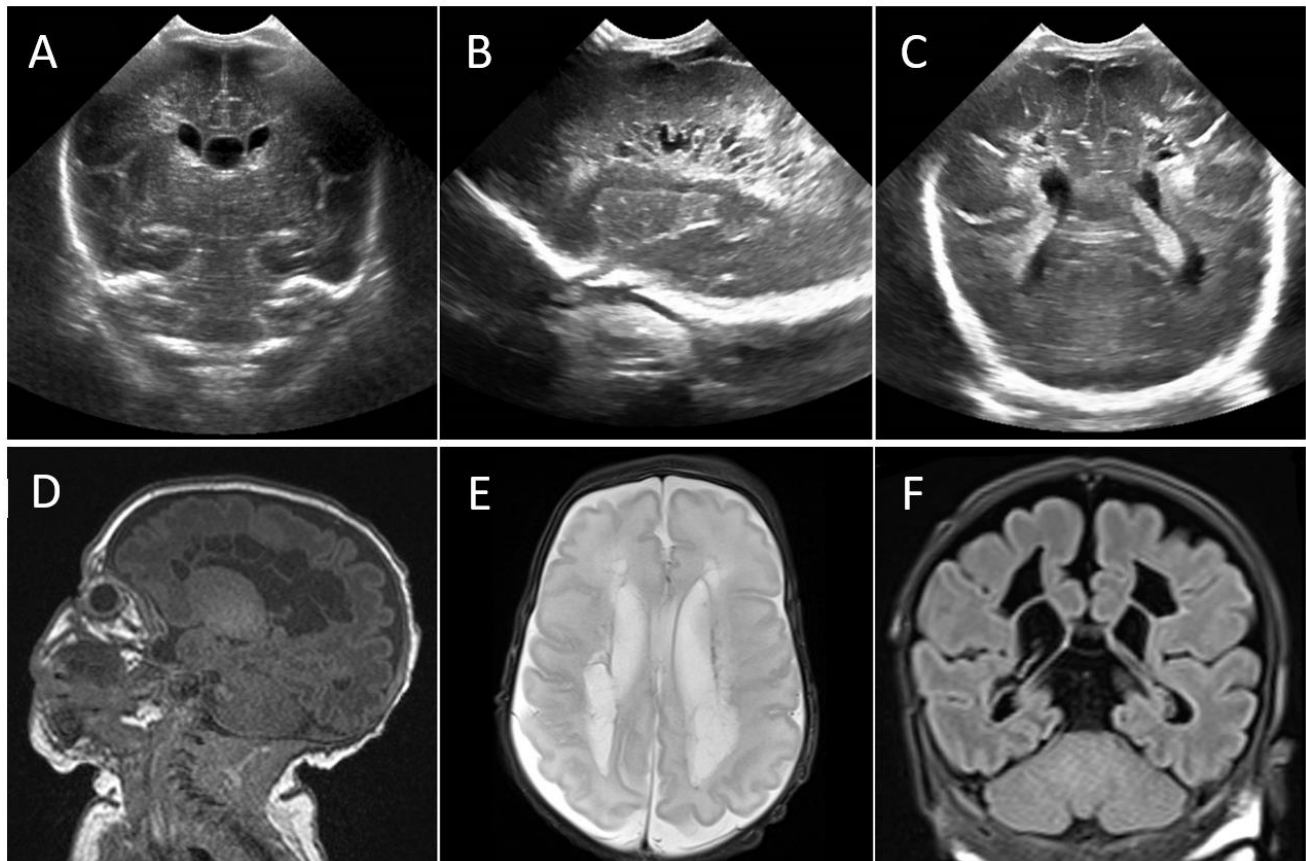
Figure 2. CASE 1: Postnatal brain imaging of the neonates. ( A ) Postnatal day 11 head ultrasound (HUS) coronal view showing a right-sided grade II intraventricular hemorrhage and a focal unilateral periventricular hemorrhagic infarction. Postnatal day 24 HUS with sagittal ( B ) and coronal ( C ) views showing extensive periventricular fronto-parieto-occipital cystic lesions. ( D ) Brain magnetic resonance imaging (MRI) on postnatal day 56 (37 + 1 weeks postmenstrual age) with sagittal T1-weighted, ( E ) axial T2-weighted, and ( F ) coronal T2-FLAIR (fluid-attenuated inversion recovery) images confirming severe periventricular cystic leukomalacia, sequelae of germinal hemorrhage, and moderate ventriculomegaly .